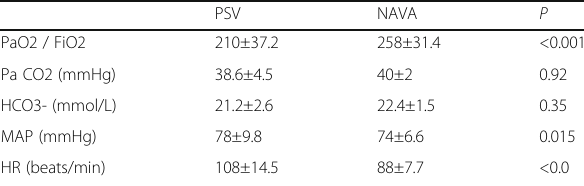
Table 2 (abstract 001630). arterial blood gases and hemodynamics during PSV and